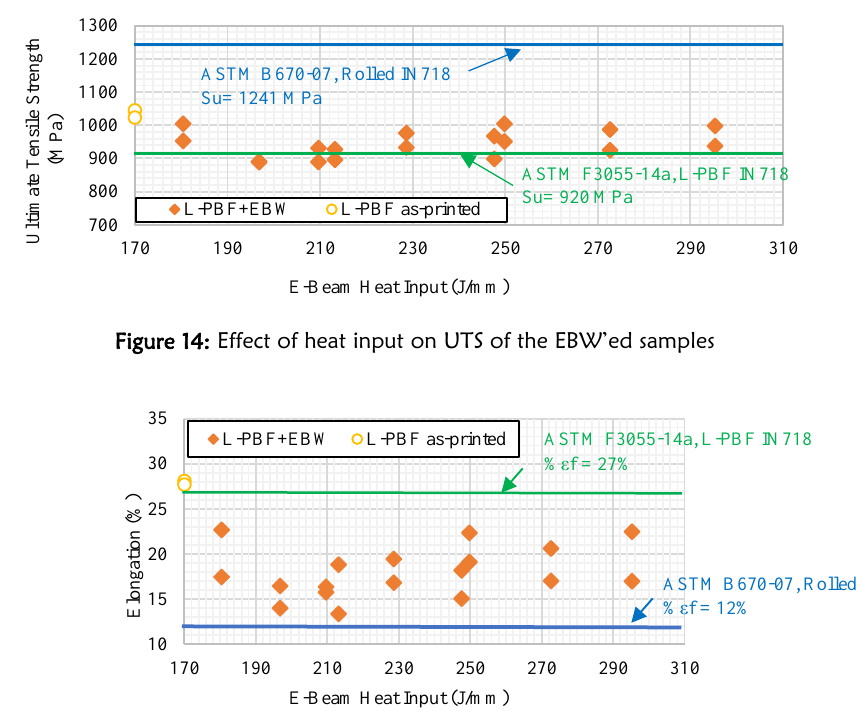
Figure 15: Effect of heat input on the elongation of the EBW’ed